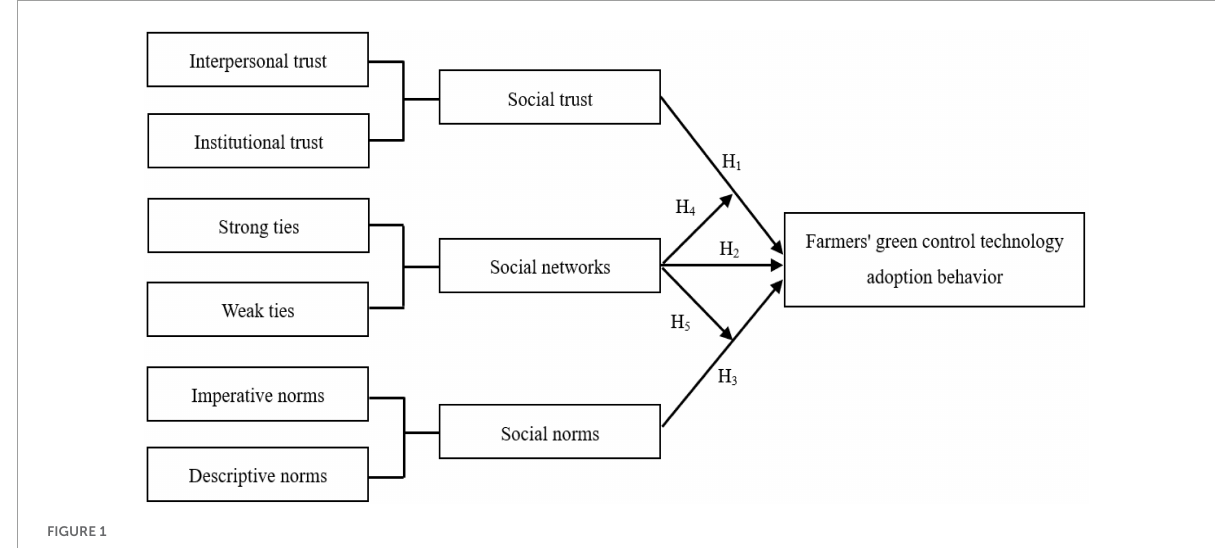
FIGURE1 Theoretical analysis